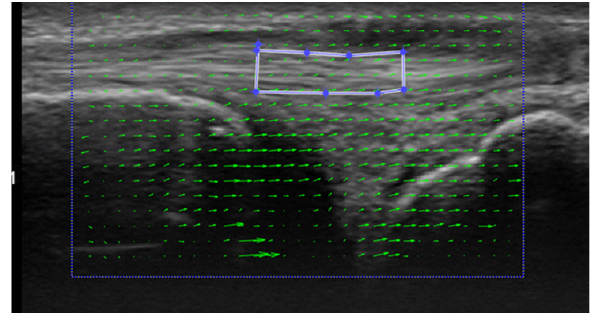
Figure 3. Analysis of extensor carpi ulnaris (ECU) velocity using particle image velocimetry. The green arrows indicate the directions of fluid movement. The smaller blue box indicates the regions of interest where we analyzed the ECU tendon at the level of the articular